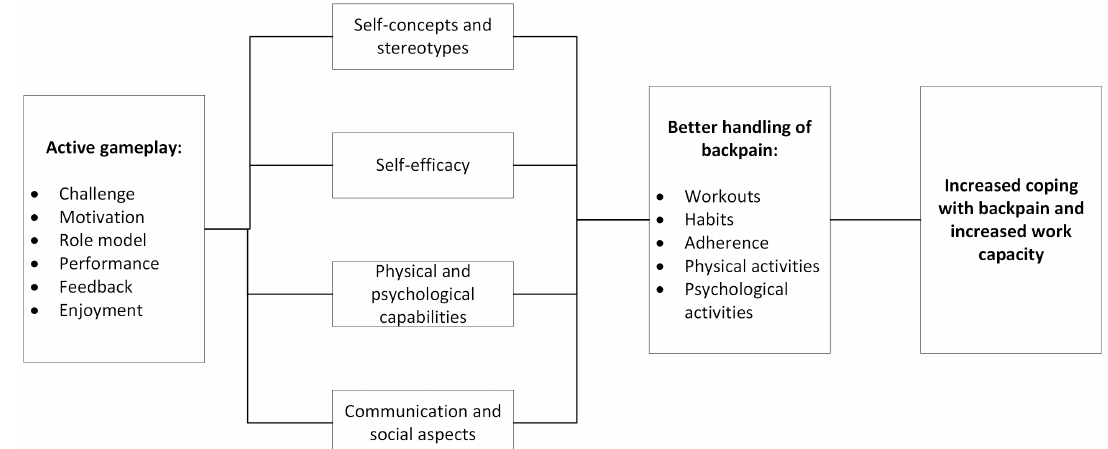
Figure 1. Challenge model of the MyRelief game.